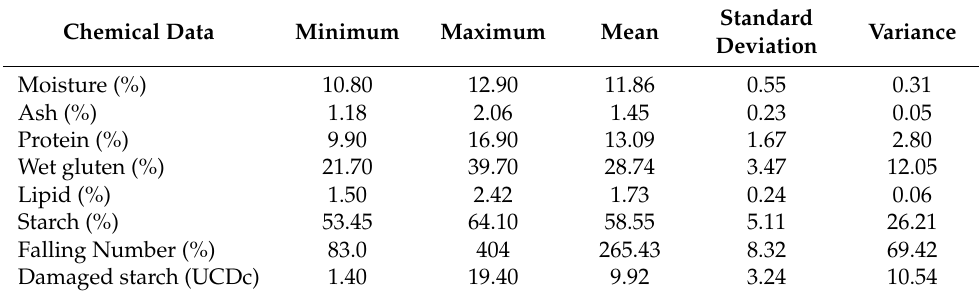
Table 3. Physicochemical characteristics of wheat